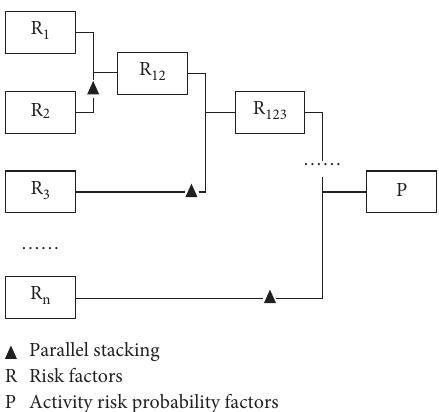
Figure 1: Risk overlay process for the CIM parallel response